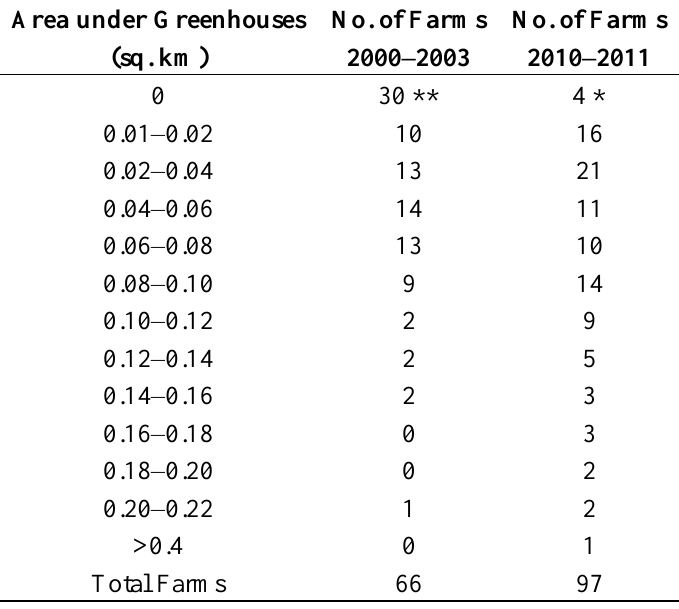
Table 1. Total land area under greenhouse cultivation, and number of greenhouses in 2000–2003 and 2010–2011 in the study